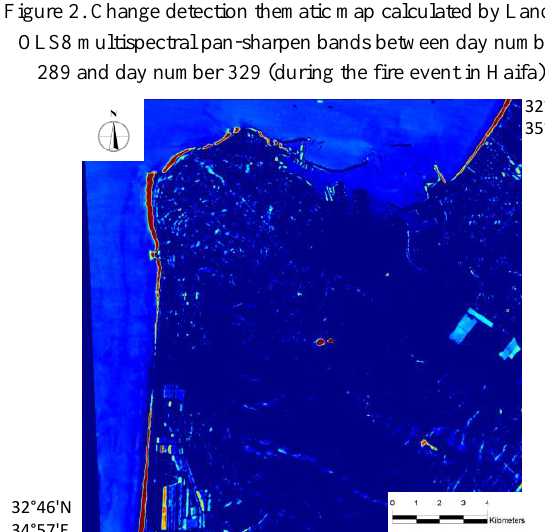
32°46'N 34°57'E Figure 3. Physical signal based change detection map calculated by Landsat OLS8 in blue no change in red the maximum change